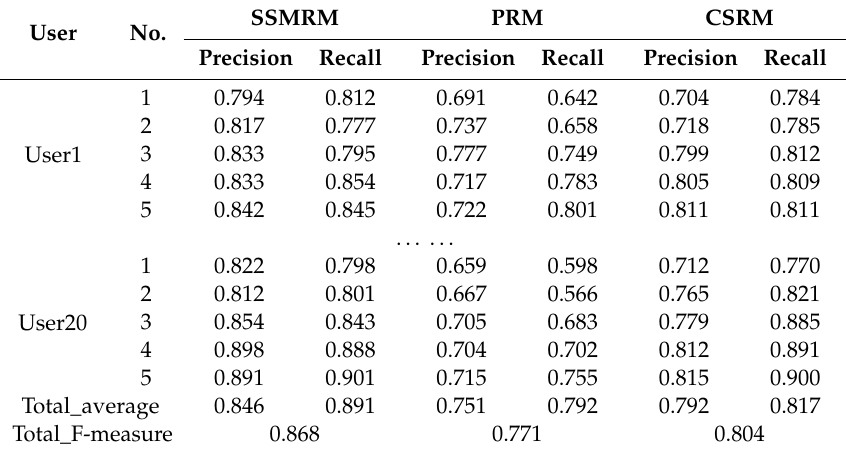
Table 3. Performance result of F-measure, recall, and